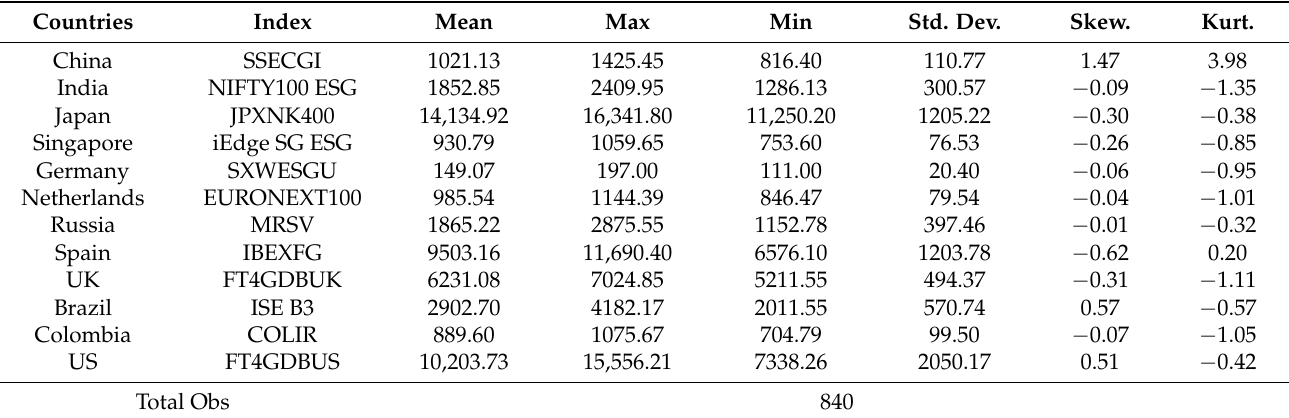
Table 1. summary statistics of Sustainable Stock Market Index in 12 Countries. Table 1. Summary statistics of Sustainable Stock Market Index in 12